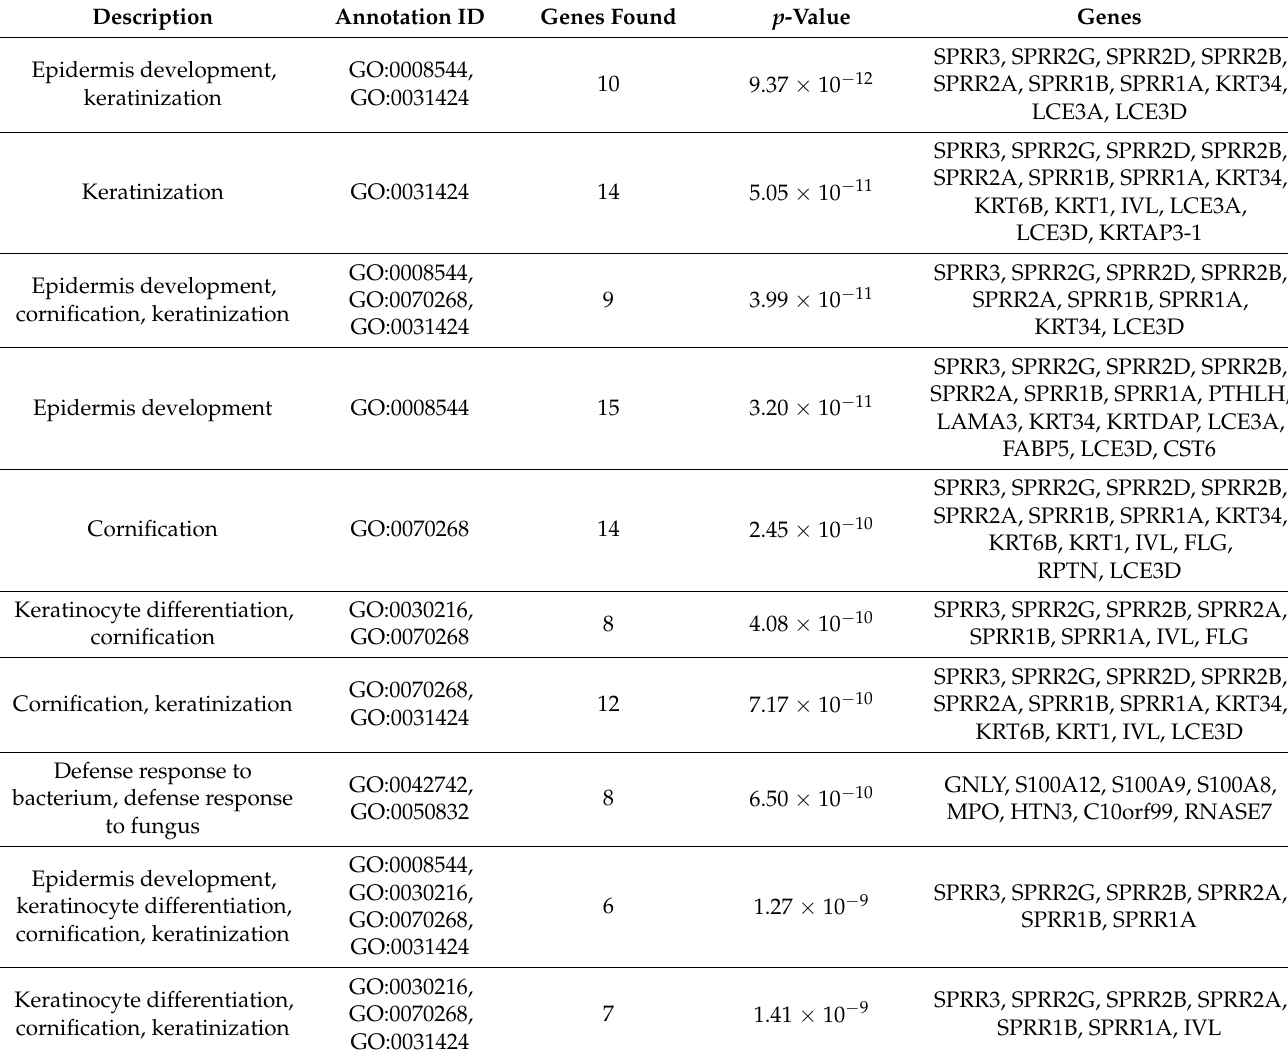
Table 1. Top 10 GO terms of upregulated DEGs.